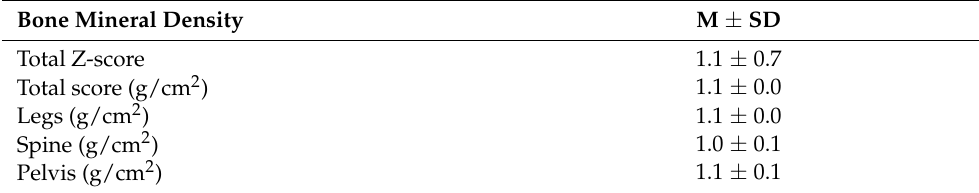
Table 6. Bone mineral density scores for dancers ( n =